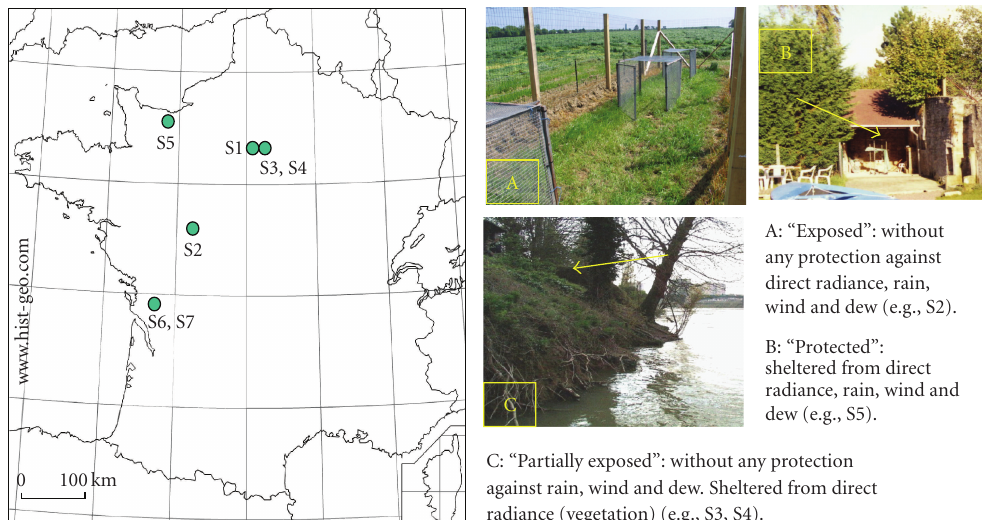
Figure 1: Location and general characteristics of the sites.